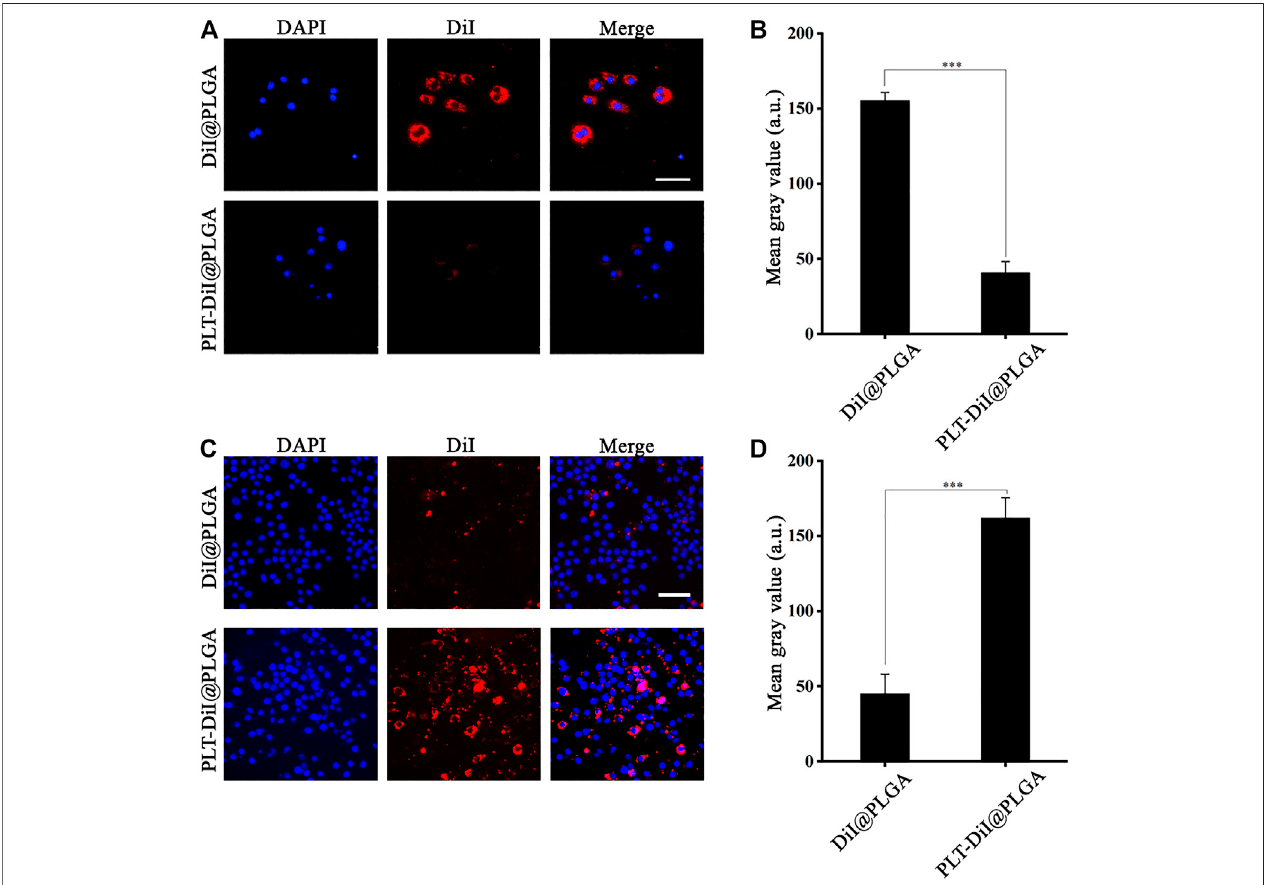
FIGURE 3 | The Fluorescence imaging of the RAW264.7 and foam cells. (A) Fluorescence images of accumulated DiI@PLGA and PLT-DiI@PLGA in RAW264.7 cells. Scale bar = 100 µm. (B) Corresponding fl uorescence intensities of RAW264.7 cells treated with DiI@PLGA and PLT-DiI@PLGA for 2.0 h (*** p < 0.001). (C) Fluorescence images of accumulated DiI@PLGA and PLT-DiI@PLGA in foam cells. Scale bar = 50 µm. (D) Corresponding fl uorescence intensities of foam cells treated with DiI@PLGA and PLT-DiI@PLGA for a 2.0 h (*** p <